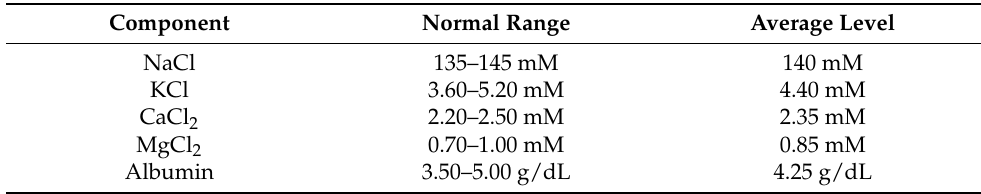
Table 2. Normal and average serum concentrations of the main ionic and protein constituents of human